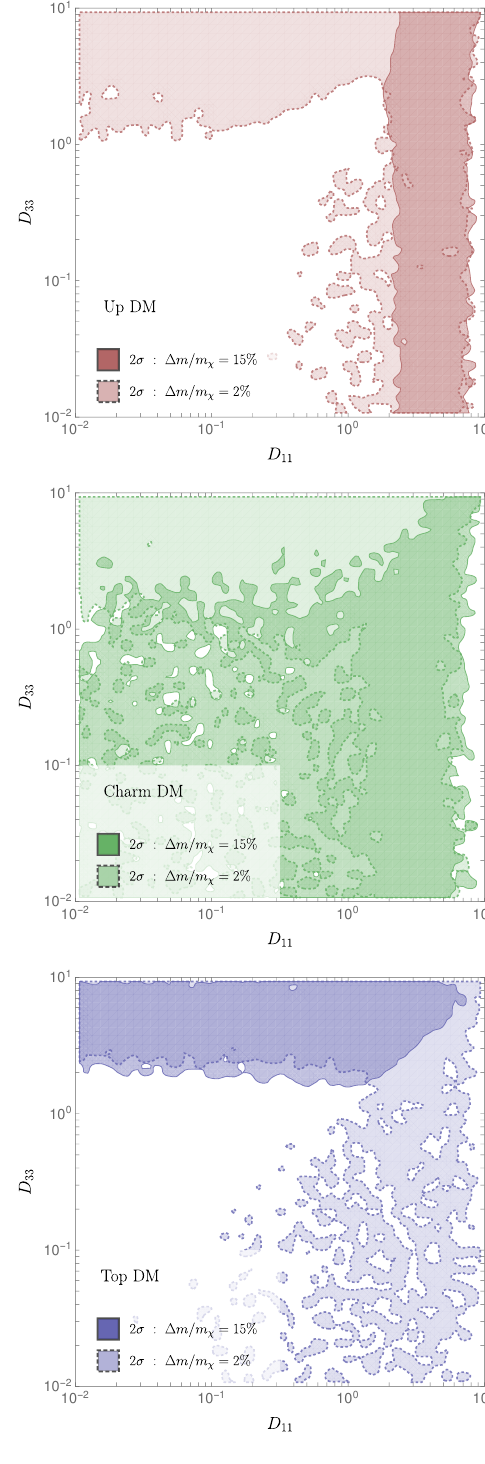
plane (left) and D (right), for two values 11 (cid:0) D 22 11 (cid:0) D 33